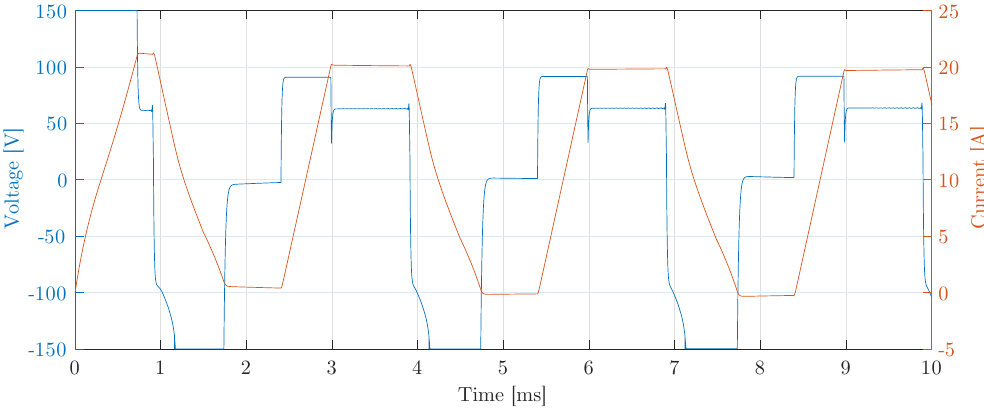
Figure 10. Dynamic simulation showing phase currents and voltages for a single phase, for the prototype. The rotational frequency was 334